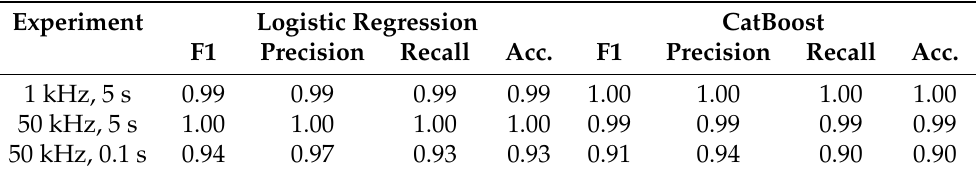
Table 7. In the current table, we report the f1-score, precision, recall and accuracy (Acc.) of the estimators for all the experiments. F1-score, precision, recall are weighted by